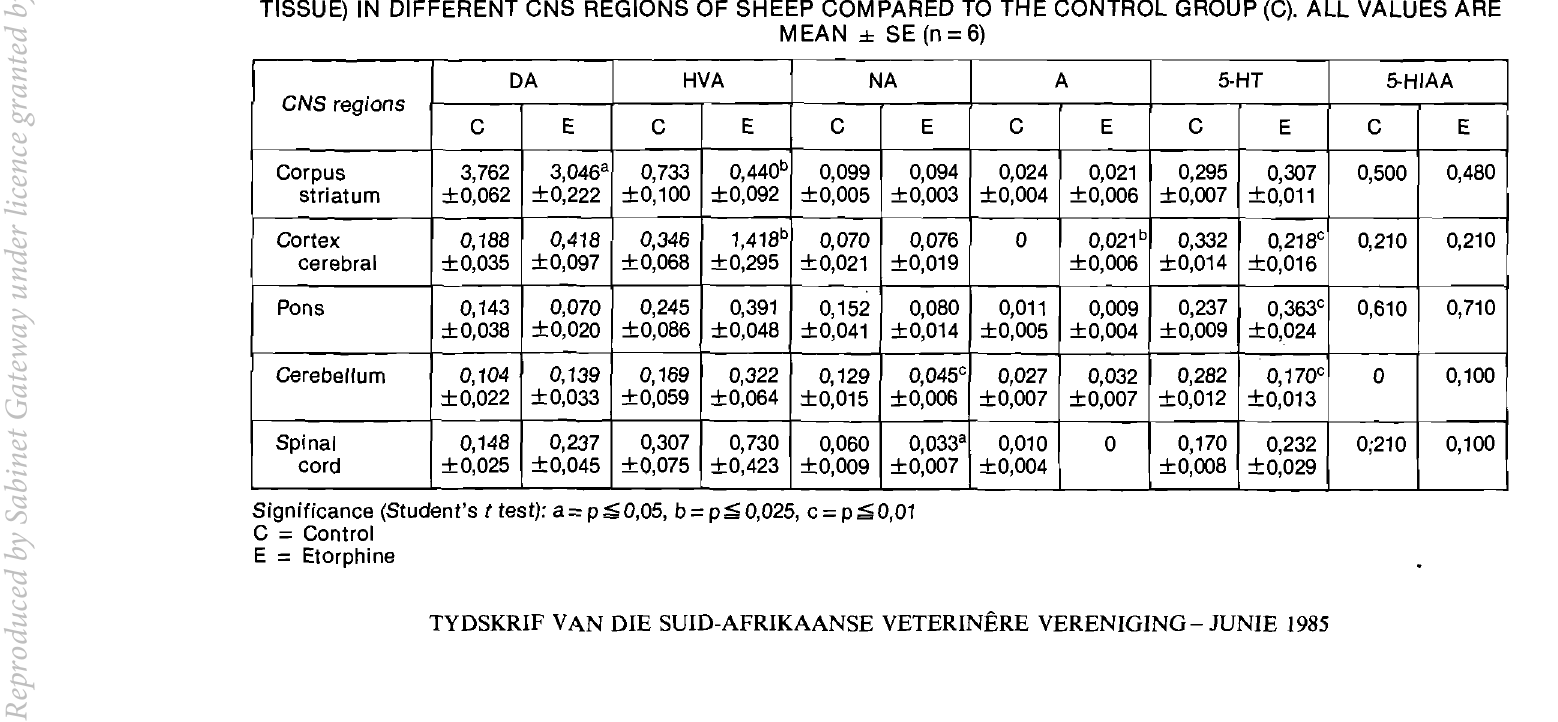
Table 1: EFFECT OF ETORPHINE ON DOPAMINE (DA), HOMOVANILIC ACID (HVA), NOR-ADRENALINE (NA), ADRENALINE (A), SEROTONIN (5-HT) AND 5-HYDROXYINDOLE ACETIC ACID (5-HIAA) CONCENTRATIONS (p.g/g - I TISSUE) IN DIFFERENT CNS REGIONS OF SHEEP COMPARED TO THE CONTROL GROUP (C). ALL VALUES